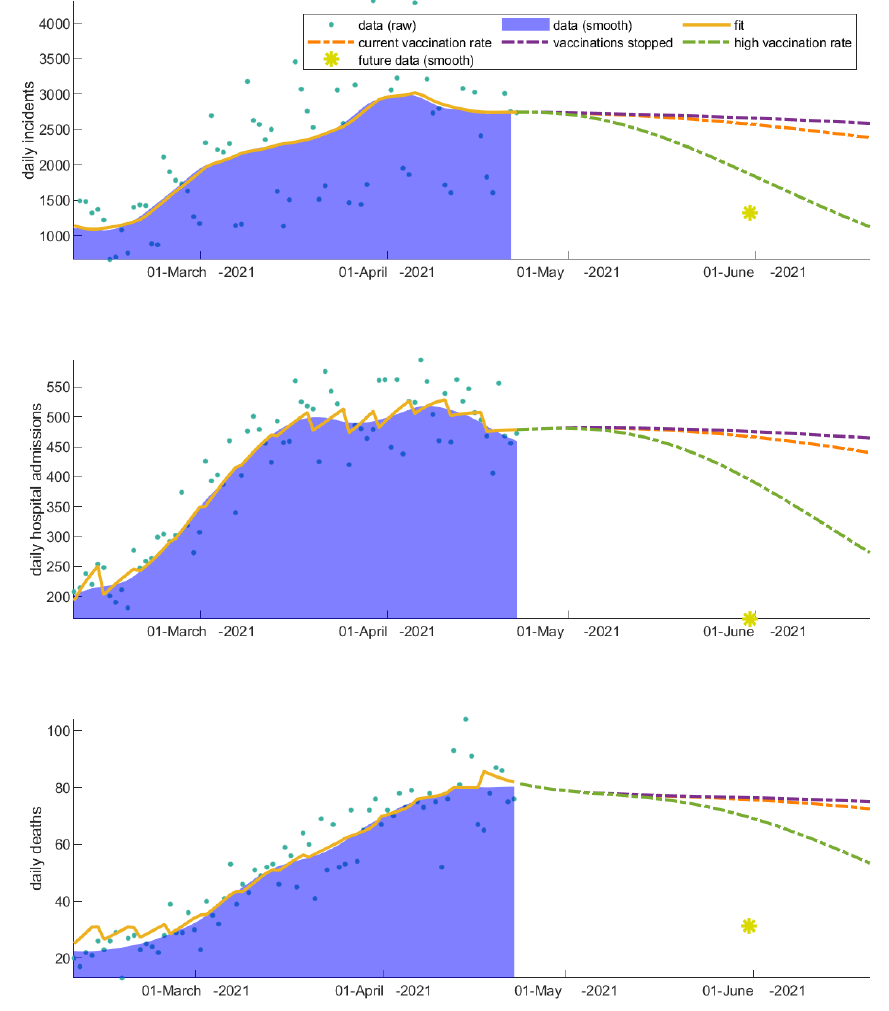
Figure 3. Impact of altering the vaccination rate after 23 April 2021 (decline of the second wave in Greece) on disease dynamics. The daily (a) incidents, (b) hospital admissions, and (c) deaths are highly reduced when the vaccination rate is increased. A three-month prediction is depicted. An indicative data point from the future (1 June 2021) is shown with a yellow asterisk for